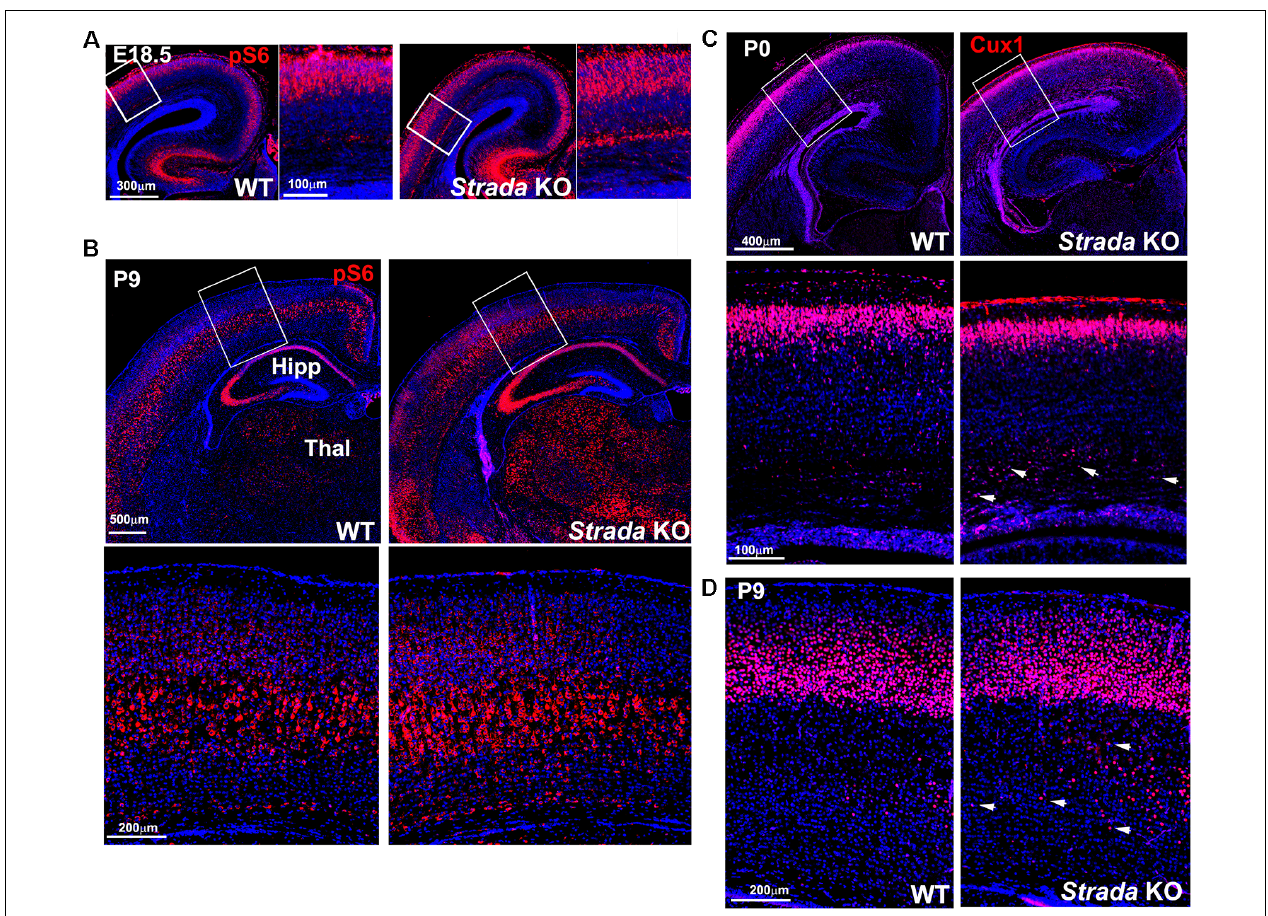
FIGURE 9 | Enhanced ribosomal S6 phosphorylation (P-S6) in Strada − / − mice evident at E18.5 (A) and P9 (B) compared with WT mouse. There is enhanced P-S6 immunoreactivity in the cerebral cortex deep layers, the thalamus (Thal), and the hippocampus (HIPP). Box depicts inset below, which shows P-S6 labeled neurons. (C) At P0, more Cux1 labeled late-born neurons (Layer II–IV) are accumulated in the intermediate zone of KO (arrows) compared with WT. (D) At P9, more Cux1 positive neurons are found in the deeper layer of the white matter of Strada KO (arrows) compared with